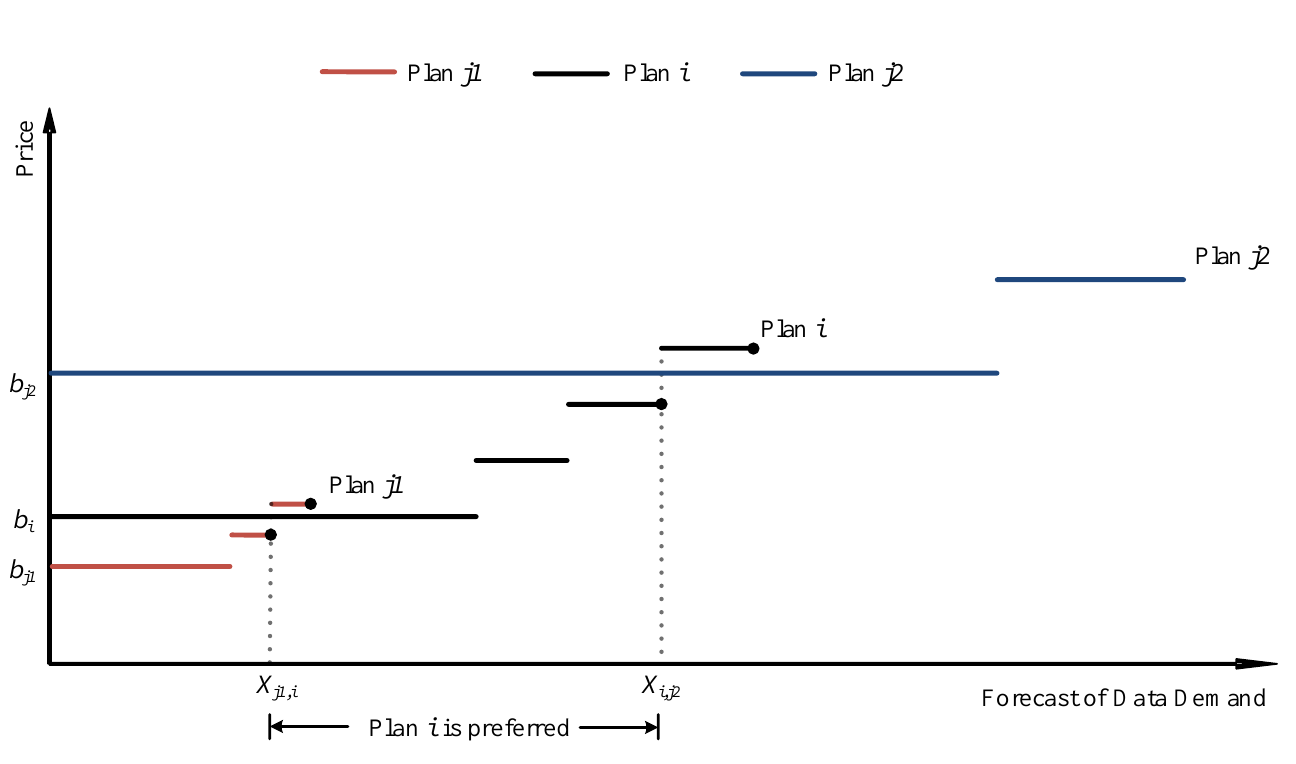
Figure 4. The interval in which plan i is